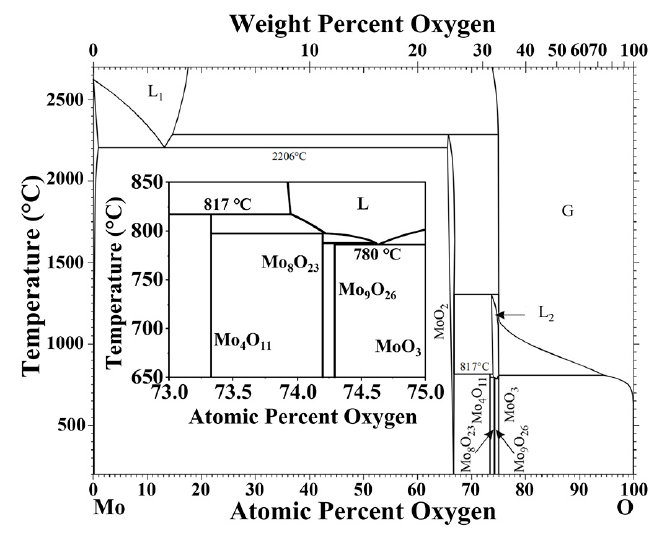
Figure 10. Mo–O binary phase diagram [35].